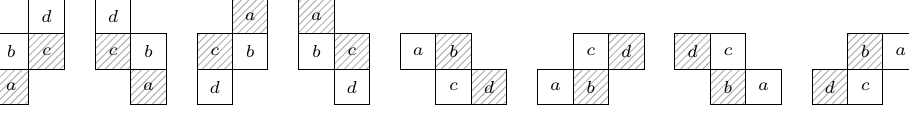
Figure 23: The eight different placements of P 4 , 5 on a checker